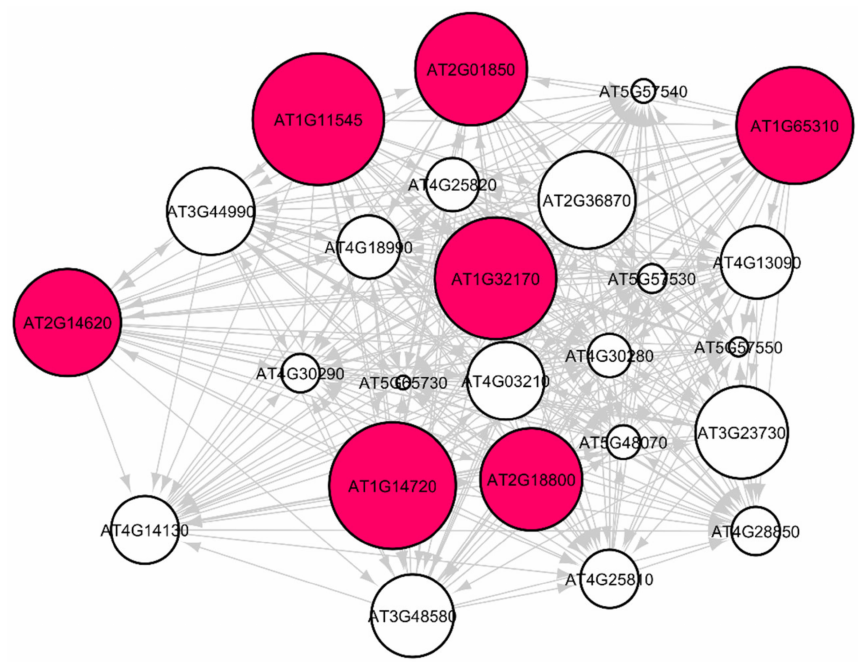
Figure 7. Gene regulatory sub-graph involving root growth genes in Arabidopsis thaliana Col-0 mutant phyD in spaceflight total light environment. The hub genes are the red circles representing the strong interactions with differentially expressed genes. The target (authority) genes are white circles. The hub genes that have a higher degree distribution are larger in